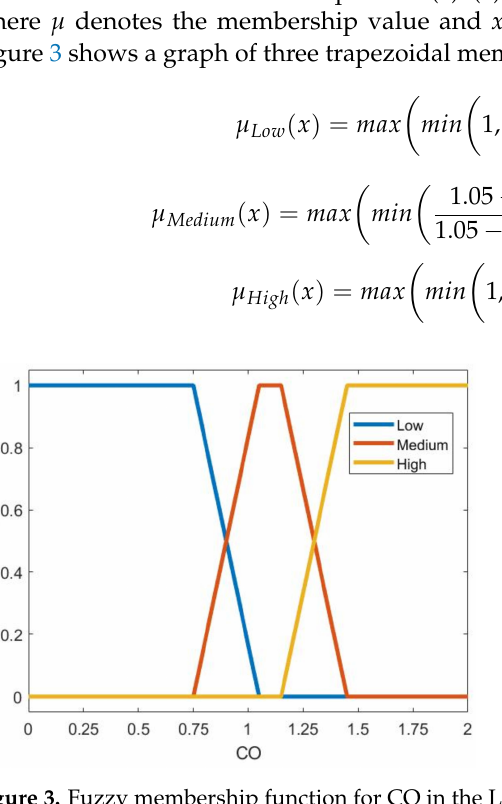
Figure 3. Fuzzy membership function for CO in the LPA-Met